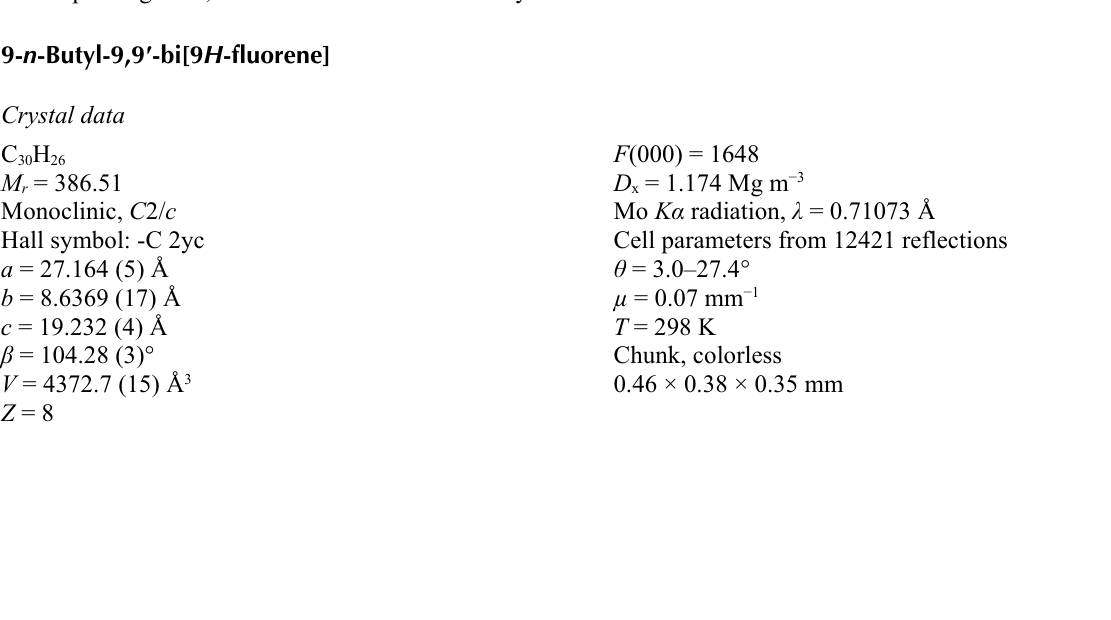
Partial packing view, H atoms are omitted for